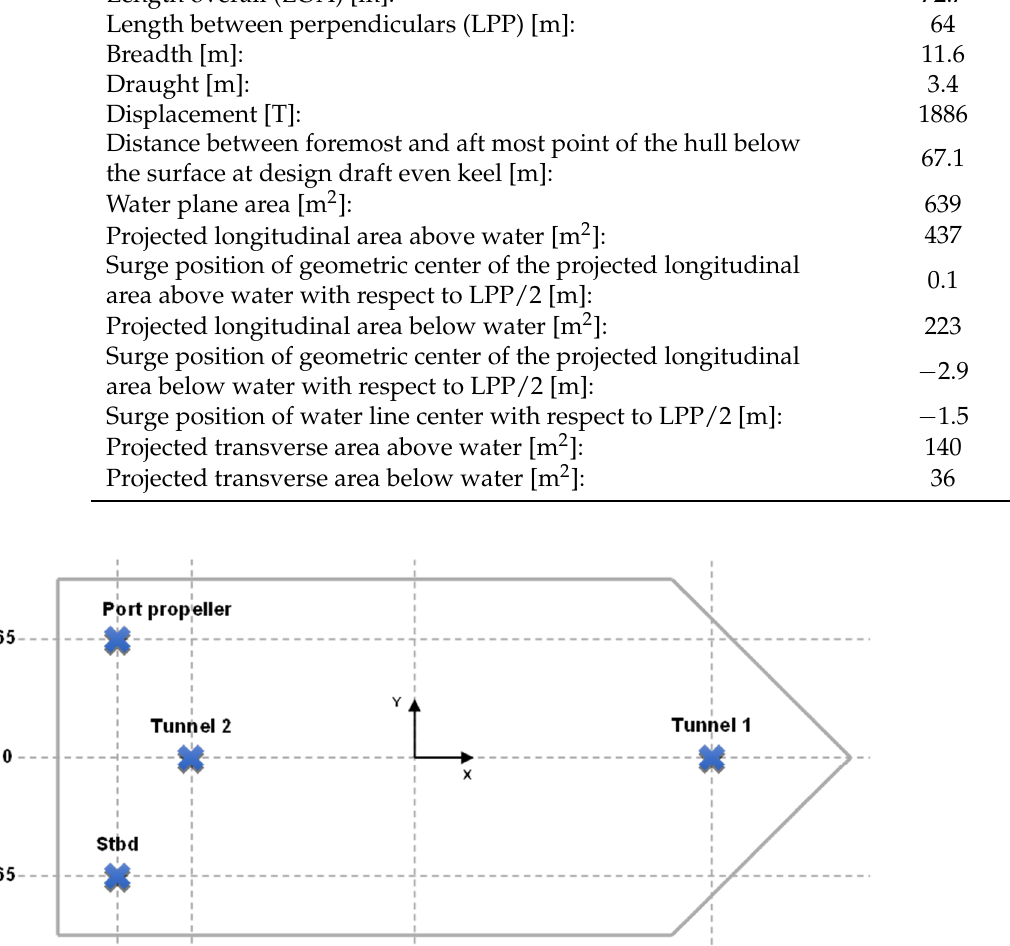
Figure 13. The result of the capability plot analysis. Apart from the thrusters listed in Table 7, the ship is equipped with a set of four anchors: two in the bow and two in the stern.